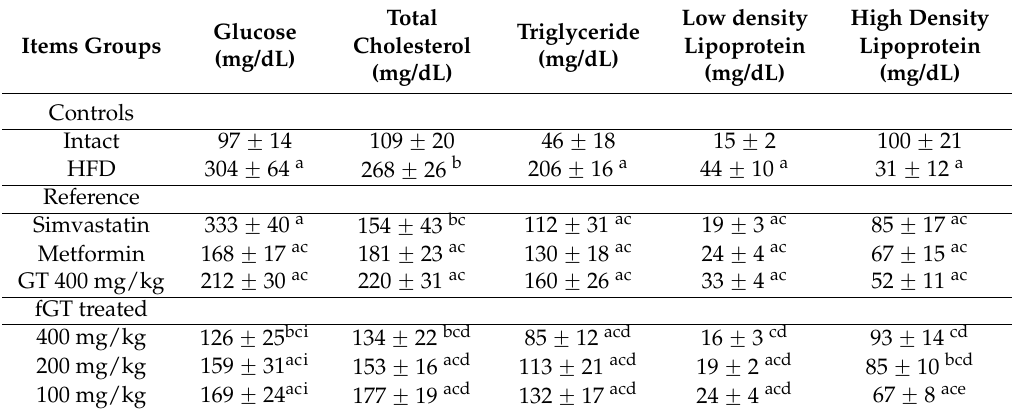
Items Groups Table 6. Changes in blood glucose levels and serum lipid contents in NFD or HFD supplied mice.